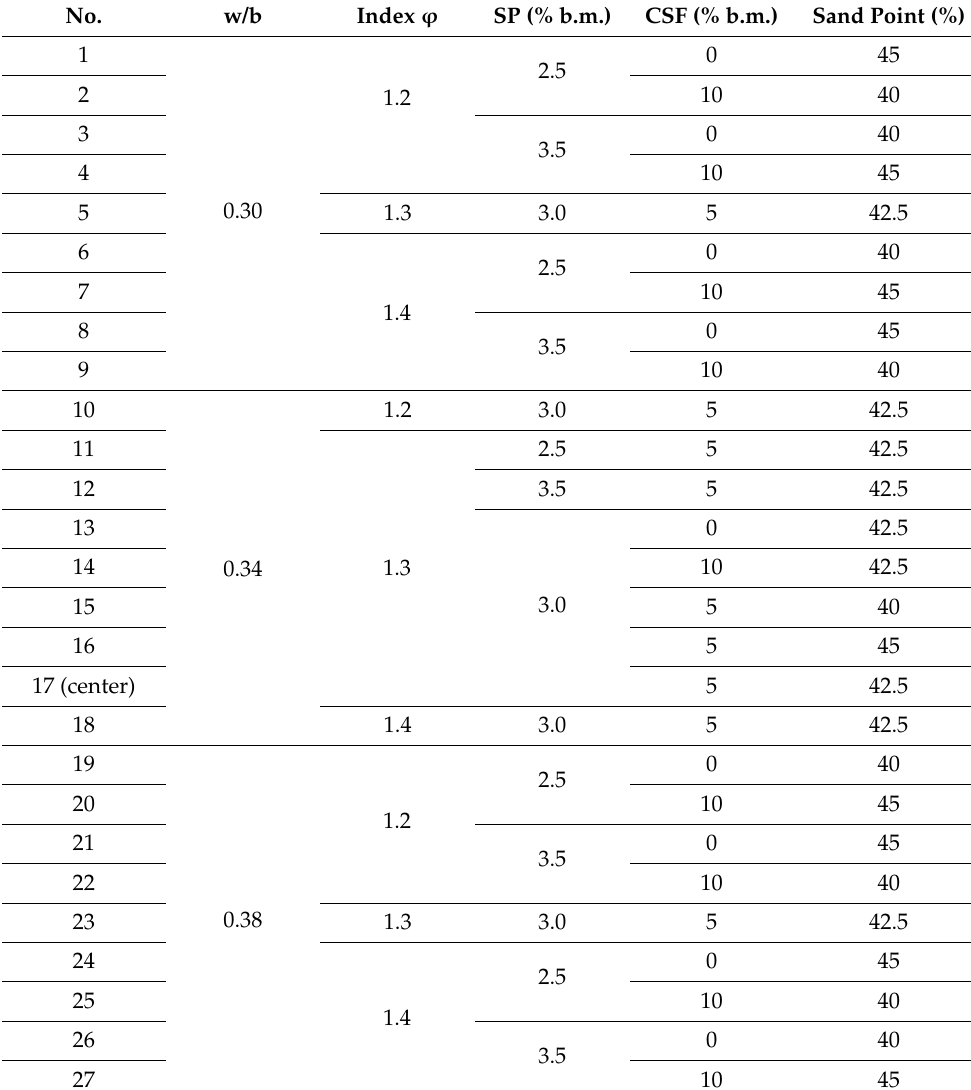
Table 6. The research plan [87].